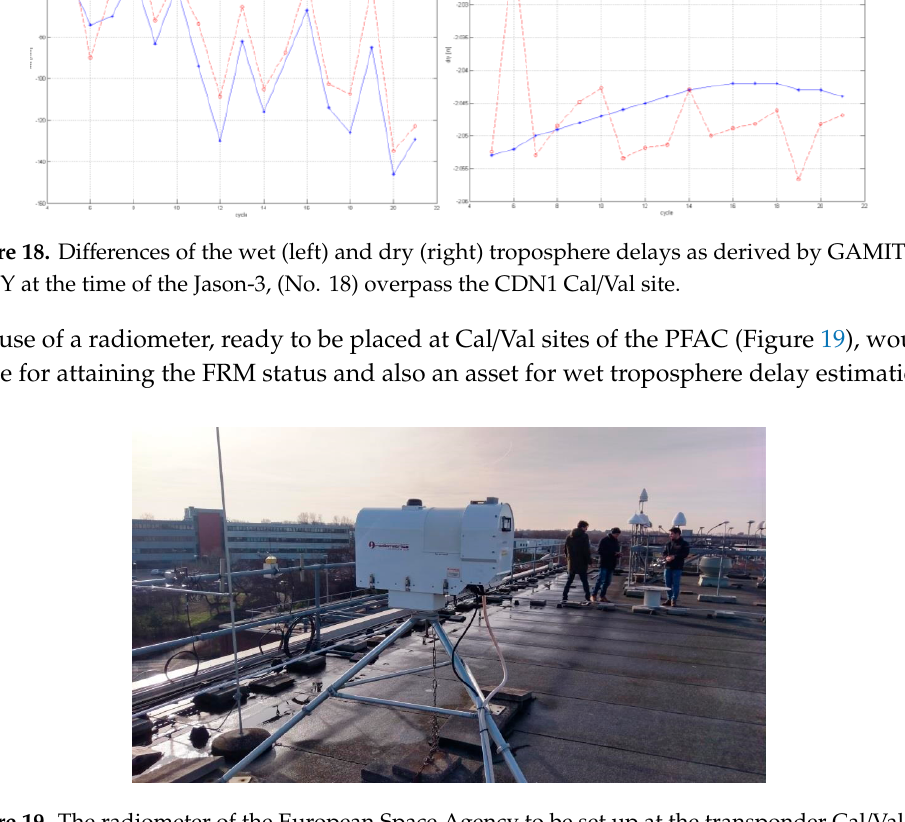
Figure 19. The radiometer of the European Space Agency to be set up at the transponder Cal/Val site.